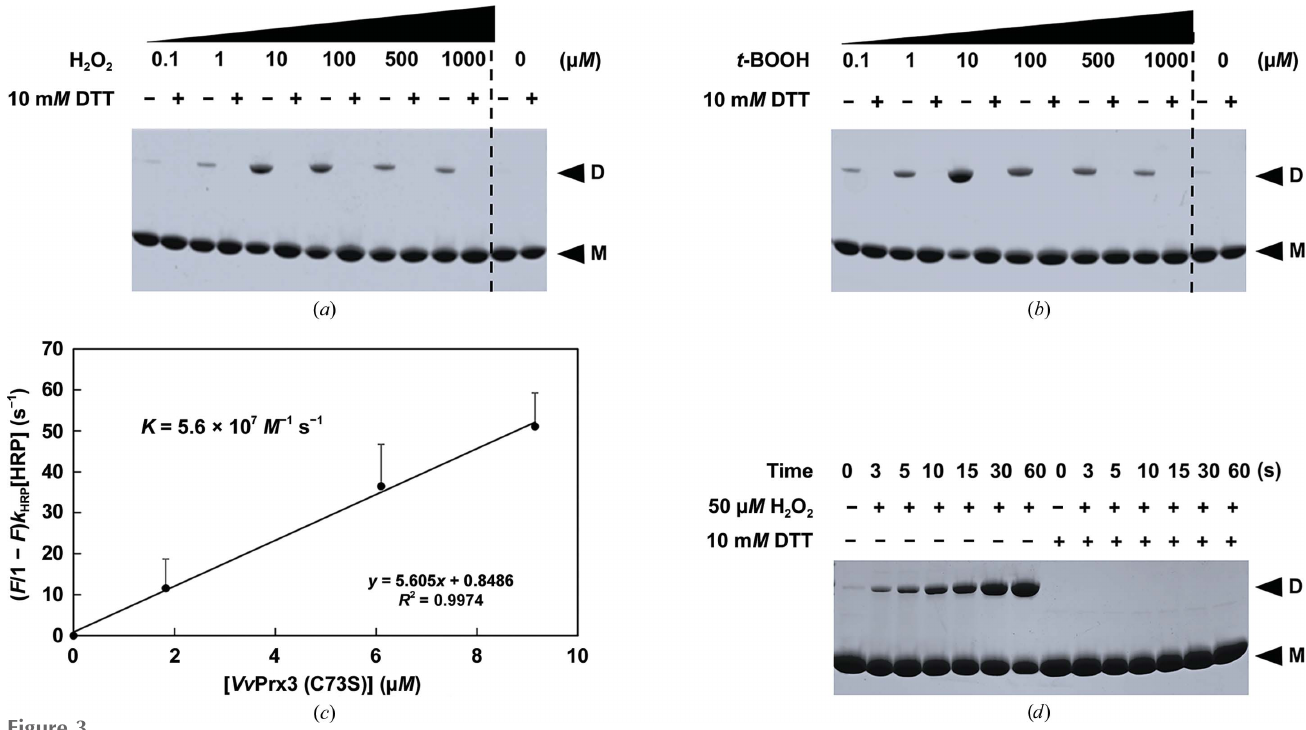
Figure 3 Intermolecular disulfide-bond formation in Vv Prx3 (C73S) on treatment with peroxide. Proteins were treated with H 2 O 2 ( a ) or tert -butyl hydrogen peroxide ( t -BOOH) ( b ) at the concentrations shown for 30 min and the reactions were stopped by adding iodoacetamide. Samples were boiled in the presence (+) or absence ( (cid:2) ) of 10 m M DTT for SDS–PAGE analysis. ( c ) Determination of the second-order reaction rate constant for the reaction of Vv Prx3 and H 2 O 2 using competition kinetics with HRP. The fitting line was calculated by the least-squares method and the error bars reflect the standard deviation from three independent experiments. ( d ) Purified Vv Prx3 (C73S) (70 m M ) was reacted with 50 m M H 2 O 2 for the given times and analyzed by SDS–PAGE. At a time of 30 s, (cid:6) 30 m M protein was linked by a disulfide bond as estimated using the density-measuring program ImageJ . The protein band for disulfide bond-containing Vv Prx3 (D) and bands that lack a disulfide bond (M) are